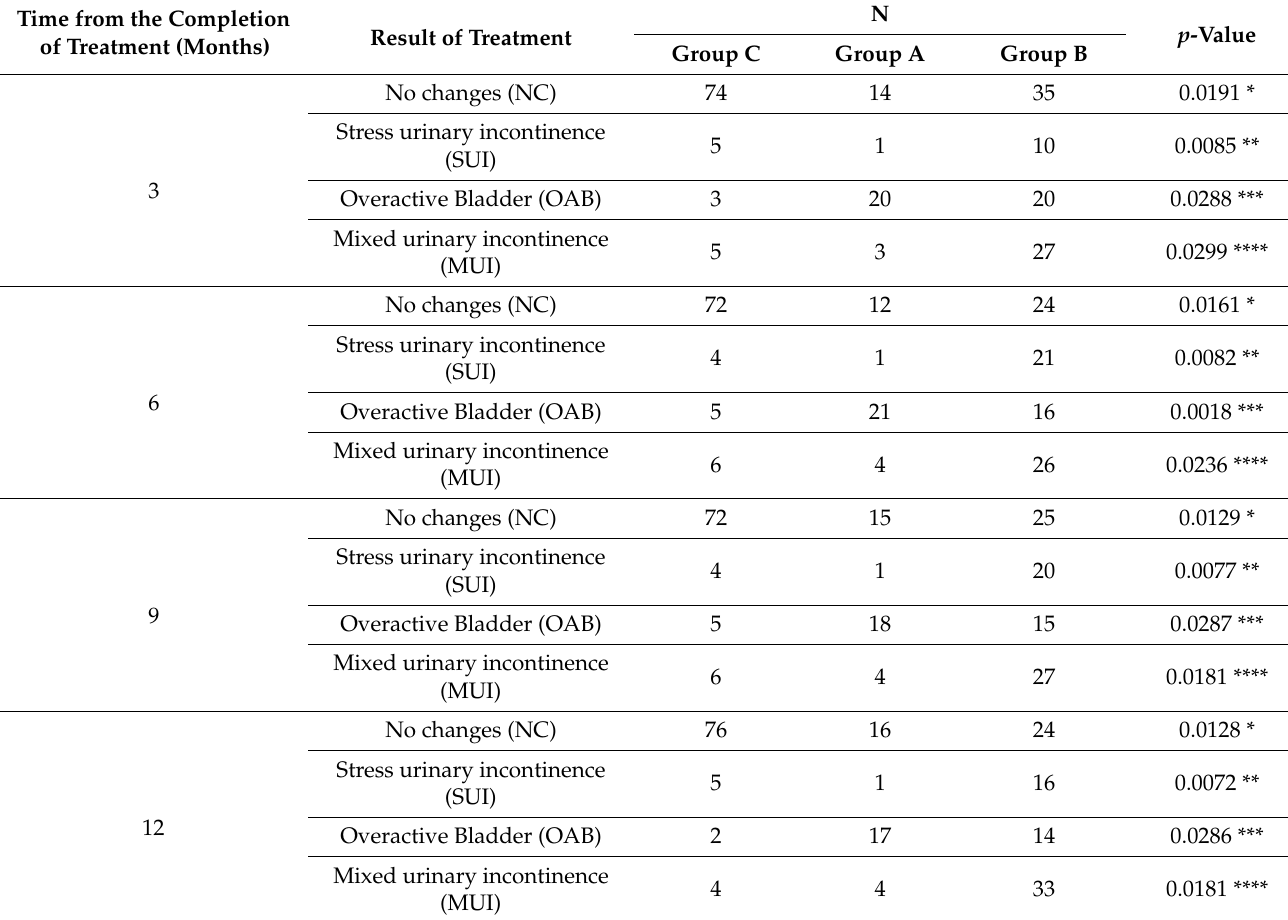
Table 1. Comparison of urogynecological examination in the study